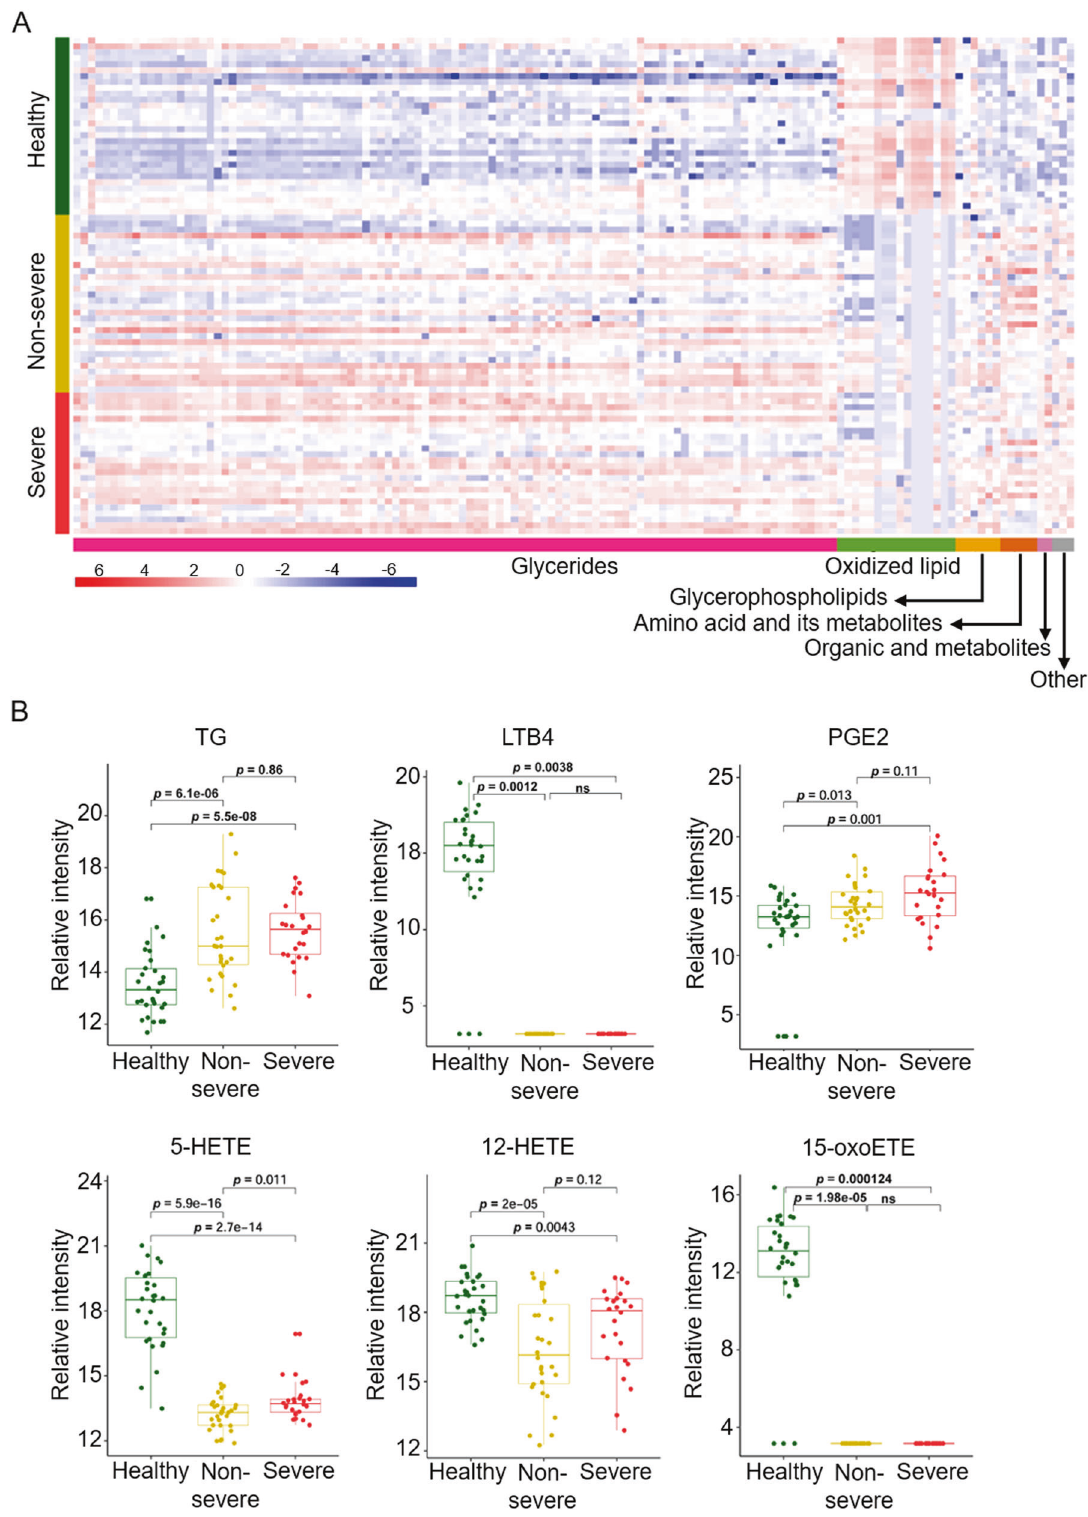
Fig. 3 Metabolomics pro fi ling of plasma samples obtained from COVID-19 survivors 6 months after discharge and healthy control subjects. A Heatmap visualization of signi fi cantly different altered metabolites (DEMs) in COVID-19 survivors at 6 months after discharge and in healthy control subjects. Metabolites included in the heatmap showed a fold-change >2 or <0.5 and p value ( t test) of <0.05. The color bar represents the relative intensity of identi fi ed proteins from − 6 to 6. B Boxplots of six elected metabolites that signi fi cantly differed between COVID-19 survivors at 6 months after discharge and healthy control subjects. For the healthy control group, n = 30; for the non-severe group, n = 30; for the severe group, n = 24. 5-HETE 5-hydroxyeicosatetraenoic acid; 12-HETE 12-hydroxyeicosatetraenoic acid; LTB4 leukotriene B4; 15- oxoETE 15-oxoeicosatetraenoic acid; PGE2 prostaglandin E2; TG triglycerides.